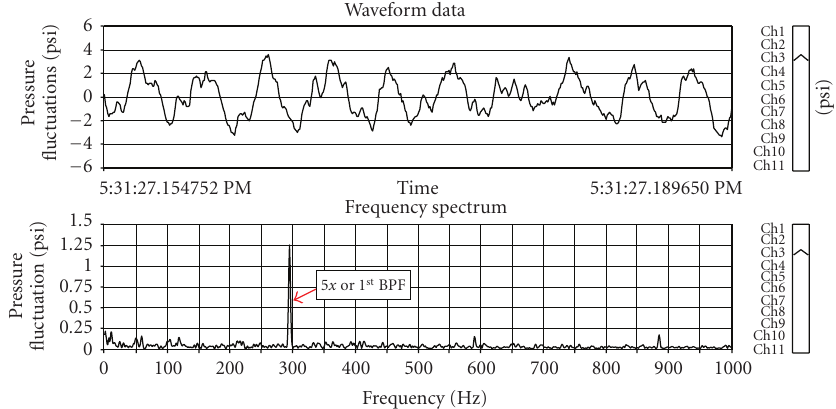
Figure 6: Waveform and frequency spectrum of pressure fluctuation at location 3, gap 3.6 mm for Impeller-I, at Q = Q n .